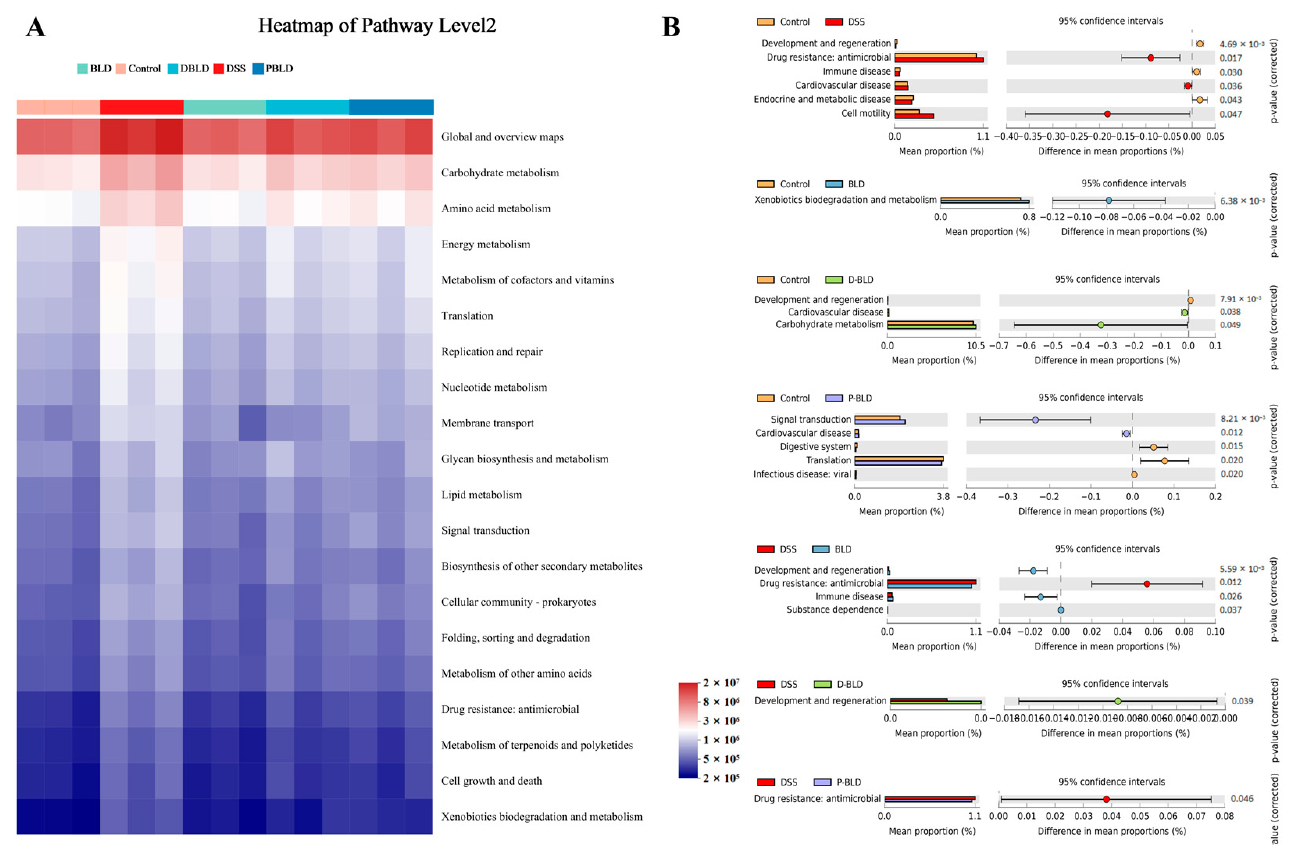
Figure 8. Predicted function of the fecal microbiome based on KEGG pathways. ( A ) Heatmap of Pathway Level2. ( B ) Important pathways associated between two groups. Statistically significant difference was performed using the unpaired two-tailed Welch’s t -test ( p < 0.05) in STAMP.